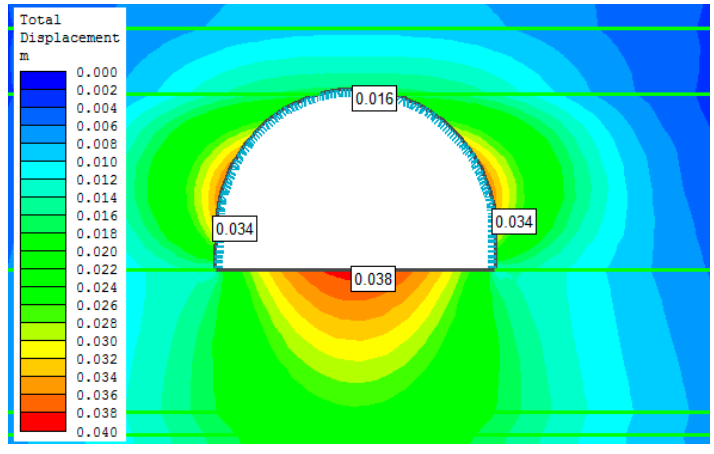
Figure 7. Elastic model no. 10—map of total displacements.